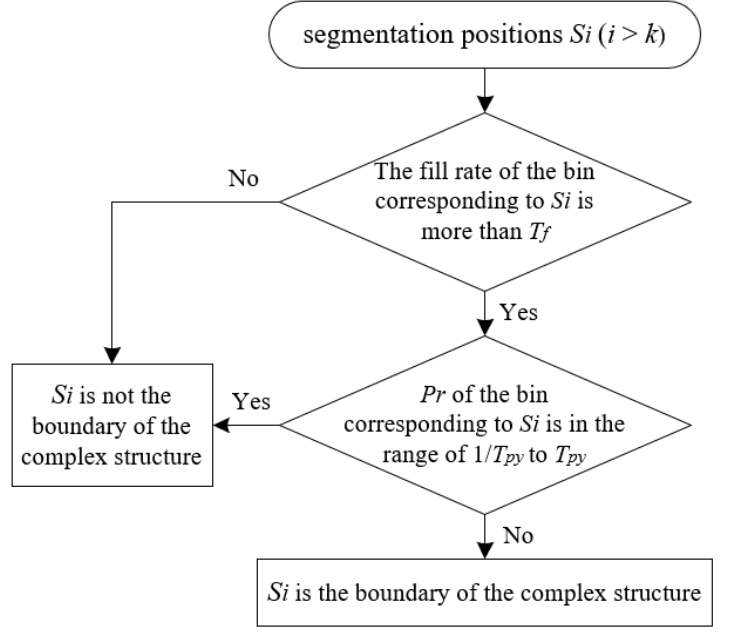
Figure 11. Point cloud around the segmentation positions: ( a ) Point cloud around the non-boundary; ( b ) point cloud around the boundary.